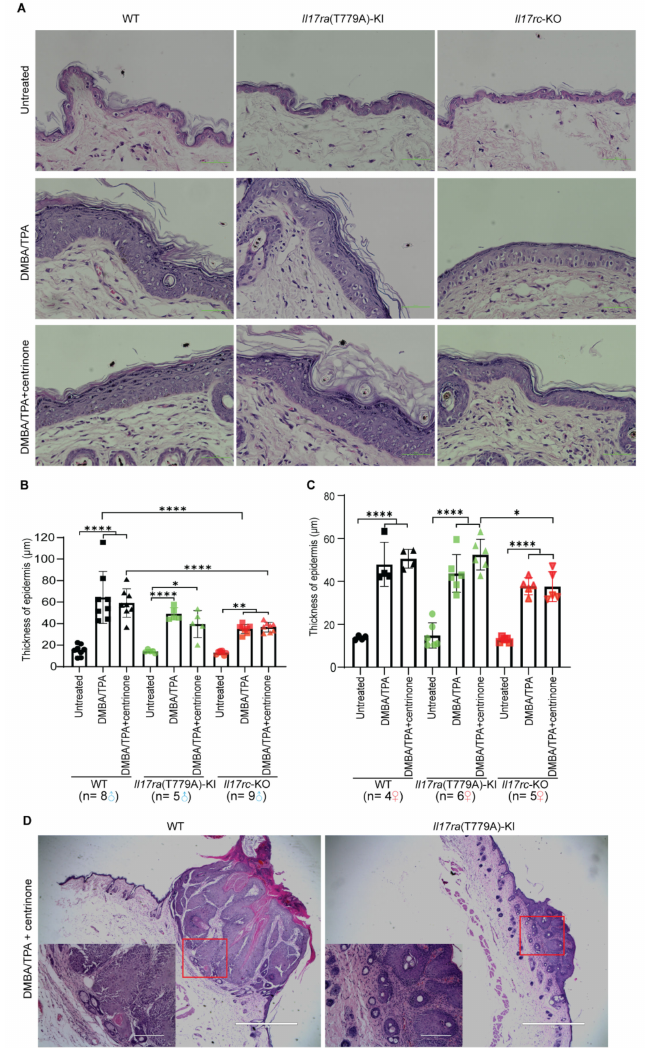
Figure 7. Knockout of Il17rc stalls proliferation of keratinocytes in the skin papilloma model. ( A ) Rep- resentatives of hematoxylin and eosin staining of skin epidermis. Scale bar represents 50 µ m. ( B , C ) Sta- tistical analysis of the thickness of the epidermis was carried out by a two-tailed Student’s t test. ( D ) Representative of hematoxylin and eosin stain of skin tumor. Scale bar represents 1000 µ m (low magnification) and 200 µ m (high magnification). Error bar represents mean ± SD. *— p < 0.05; **— p < 0.01; ****— p < 0.0001. The numbers of male and female mice in each group are indicated in the